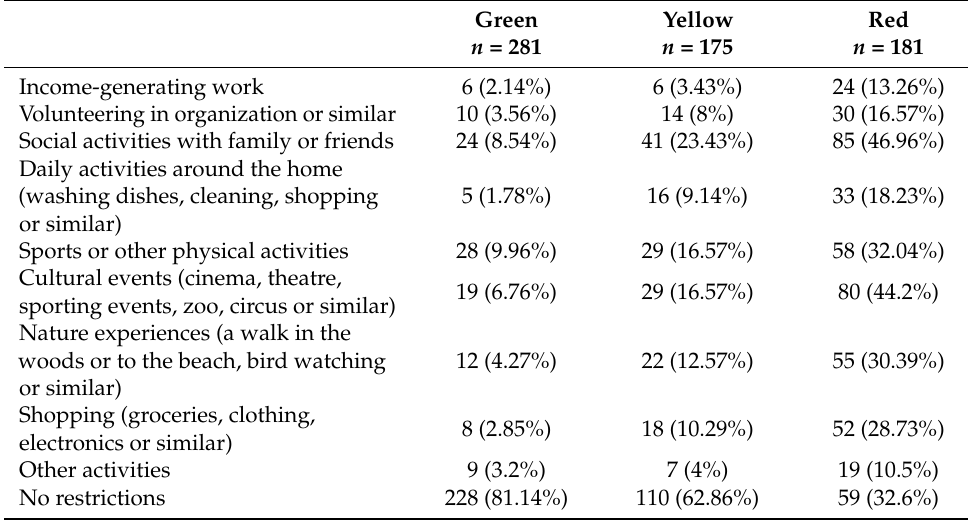
Table 4. Self-reported restriction in various aspects of daily life within the three MENTOR groups.